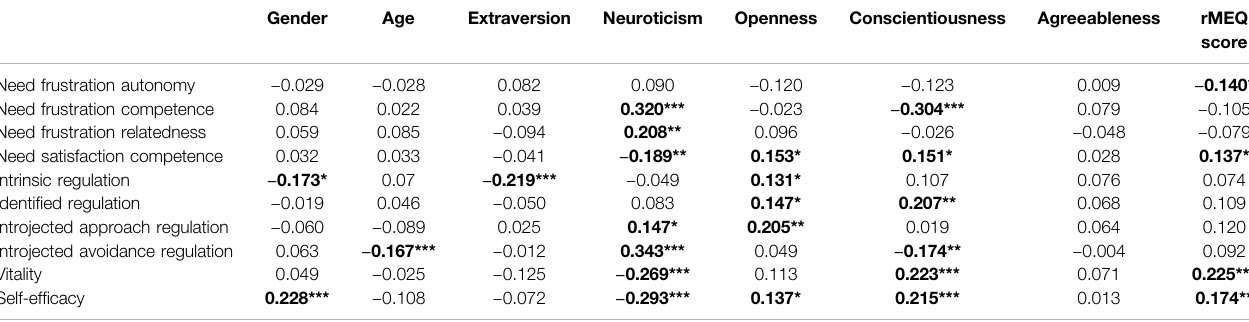
TABLE4| Resultsofthemultipleregressions.Fullmodelsarepresentedin Table3 .Standardizedcoef fi cientbetaforthepredictorvariablesisgiven.Predictorsweregender, age, personality and rMEQ score. Dependent variables were basic psychological need satisfaction and frustration, motivational regulation, vitality, and self-ef fi